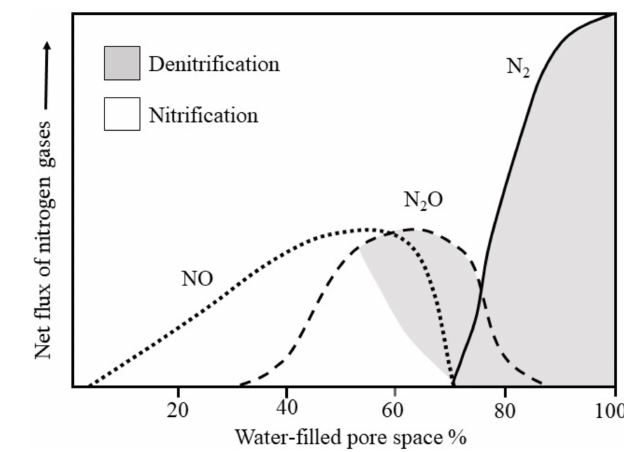
Figure 1. Relative contributions of nitrification and denitrification processes to N 2 O production as a function of water-filled pore space (adapted from Davidson,